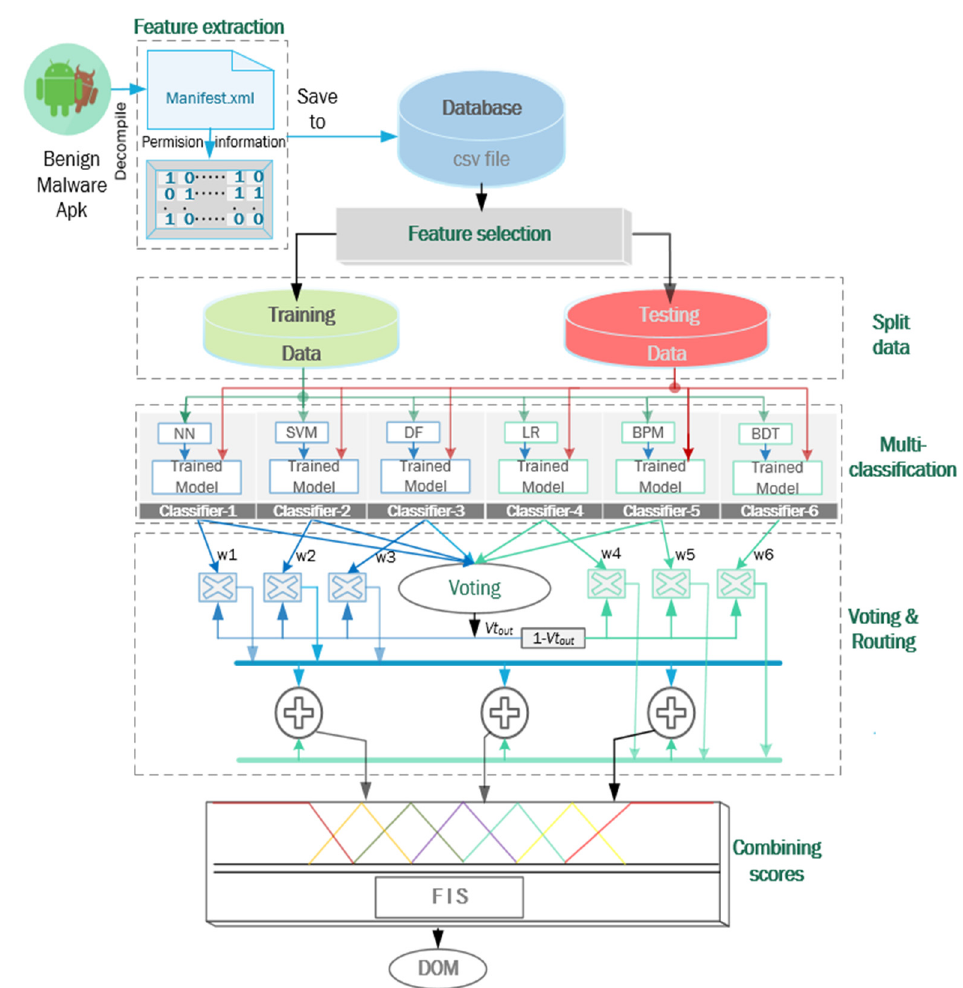
Figure 1. The schematic structure of the dynamic model proposed for Android malware detection.